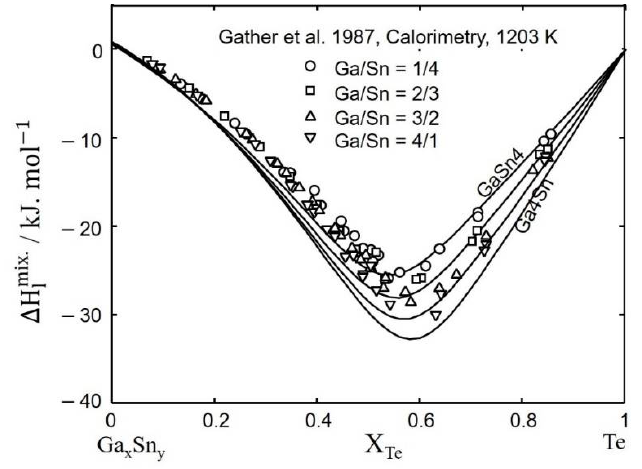
Figure 8. Calculated enthalpy of mixing in liquid Ga x Sn y -Te at 1203 K along with experimental data from [86].